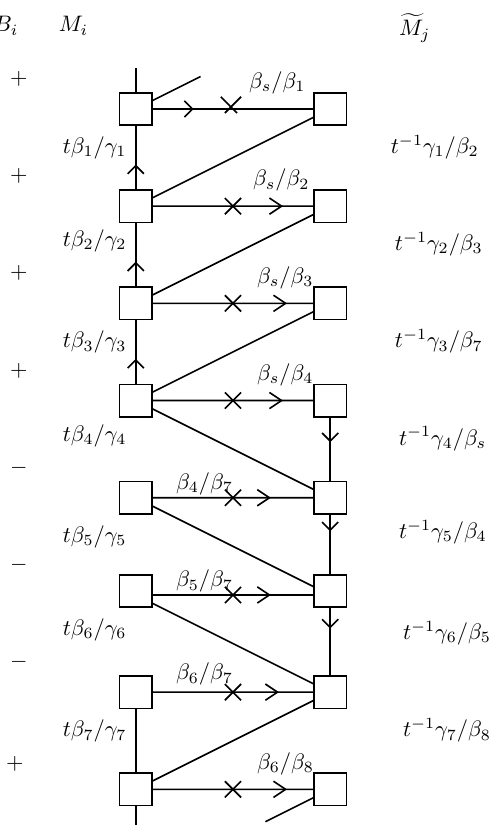
Figure 22 . Example of a tube in the four dimensional language. Note this di(cid:11)ers from what we have de(cid:12)ned before by horizontal (cid:12)elds which are chiral (cid:12)elds associated to punctures. The signs B i correspond to boundary conditions. We denote the charge of operators M i and f M j for the two punctures as manifest in their fugacities. The charges of bifundamental (cid:12)elds are denoted in their fugacities. The missing fugacities can be derived by demanding superpotential terms for every face of the quiver. The R charges of (cid:13)ipped (cid:12)elds are zero, (cid:13)ip (cid:12)elds are two, and (cid:12)elds which are not (cid:13)ipped are one. The permutation is ( : : : 1 2 3 7 8 : : : ) ( : : : 6 5 4 s : : :